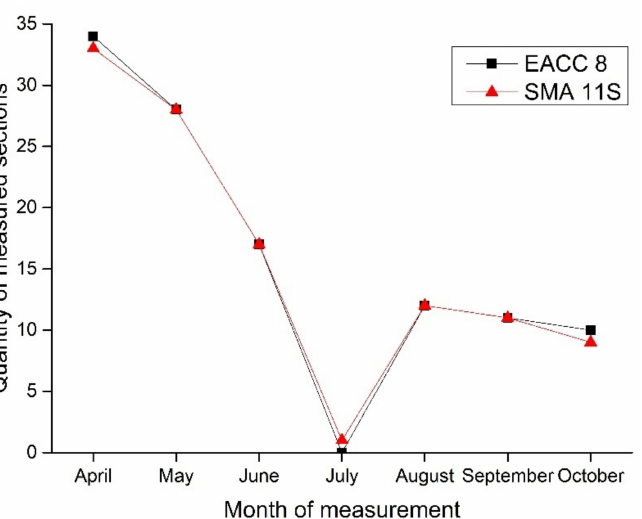
Figure 6. Number of measured sections within the framework of the monitored sections of motorway by month of the